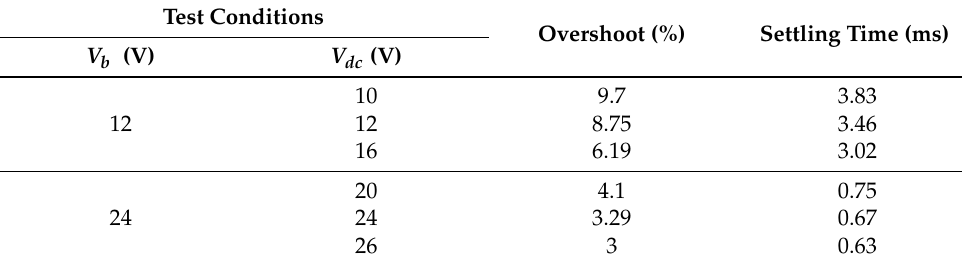
Figure 16. Performance with V b = 24 V and reference voltage V dc Table 3. Summary of the dynamic performance for bus voltage